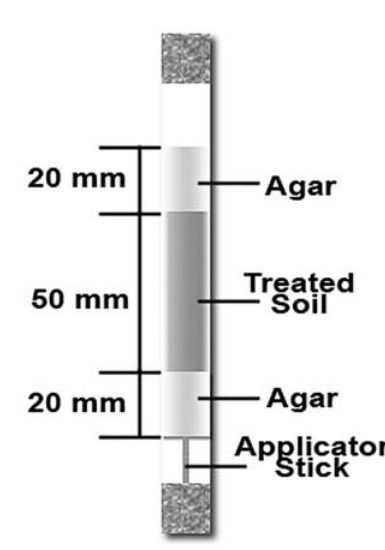
Fig. 1. Schematic showing components of glass-tube arenas used in FST feeding cessation experiment (.Waare